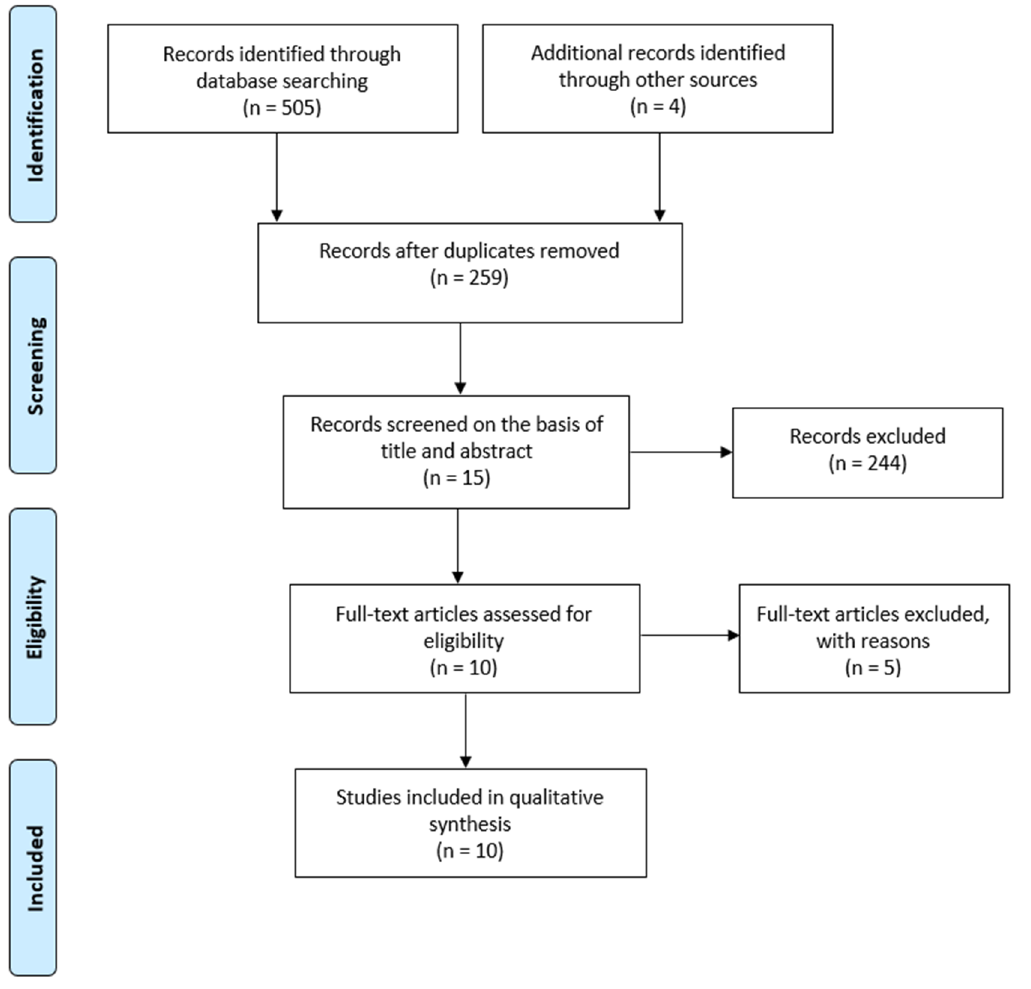
Figure 1. Flow chart of selection process.